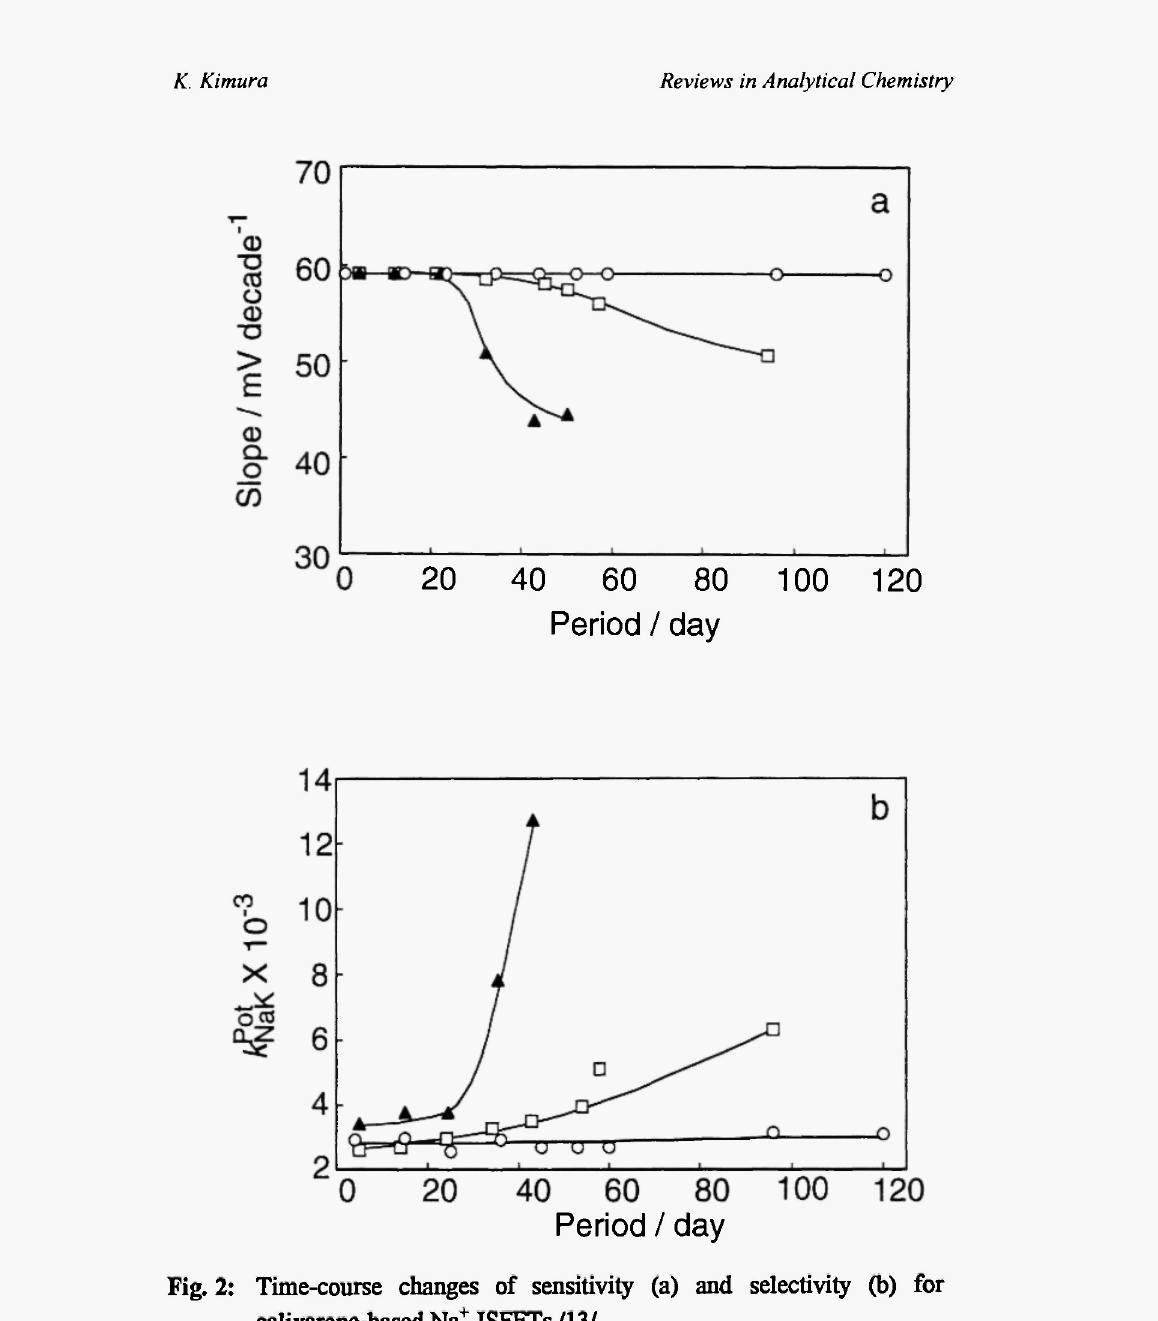
Fig. 2: Time-course changes of sensitivity (a) and selectivity (b) for calixarene-based Na + -ISFETs /13/. Silicone rubber / 1 (90/10 wt%) membrane (O), PVC/DOS / 1 (30/60/10 wt%) membrane (•), PVC/DOS / 2 (30/60 / 10 wt%) membrane (A) (DOS is 2-ethylhexyl